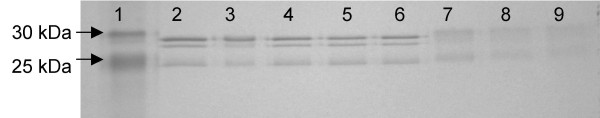
SDS PAGE analysis of α-haemolysin irradiated with 20 μM methylene blue and laser light doses of 1.93 J/cm2, 3.86 J/cm2 and 9.65 J/cm2. α-haemolysin was either kept in the dark (L-) or irradiated with laser light doses of 1.93 J/cm2, 3.86 J/cm2 and 9.65 J/cm2 (L+) in the presence of an equal volume of either PBS (S-) or 20 μM methylene blue (S+) Following irradiation, samples were analysed by SDS PAGE using a 5% stacking gel and 15% resolving gel under denaturing conditions. Lane 1: molecular weight marker, lane 2: L-S-, lane 3: L-S+, lane 4: L+S- (1.93 J/cm2), lane 5: L+S- (3.86 J/cm2), lane 6: L+S- (9.65 J/cm2), lane 7: L+S+ (1.93 J/cm2), lane 8: L+S+ (3.86 J/cm2), lane 9: L+S+ (9.65 J/cm2). L = samples exposed to laser light and S = samples exposed to 20 μM methylene blue. The apparent molecular mass of α-haemolysin was approximately 29 kDa.